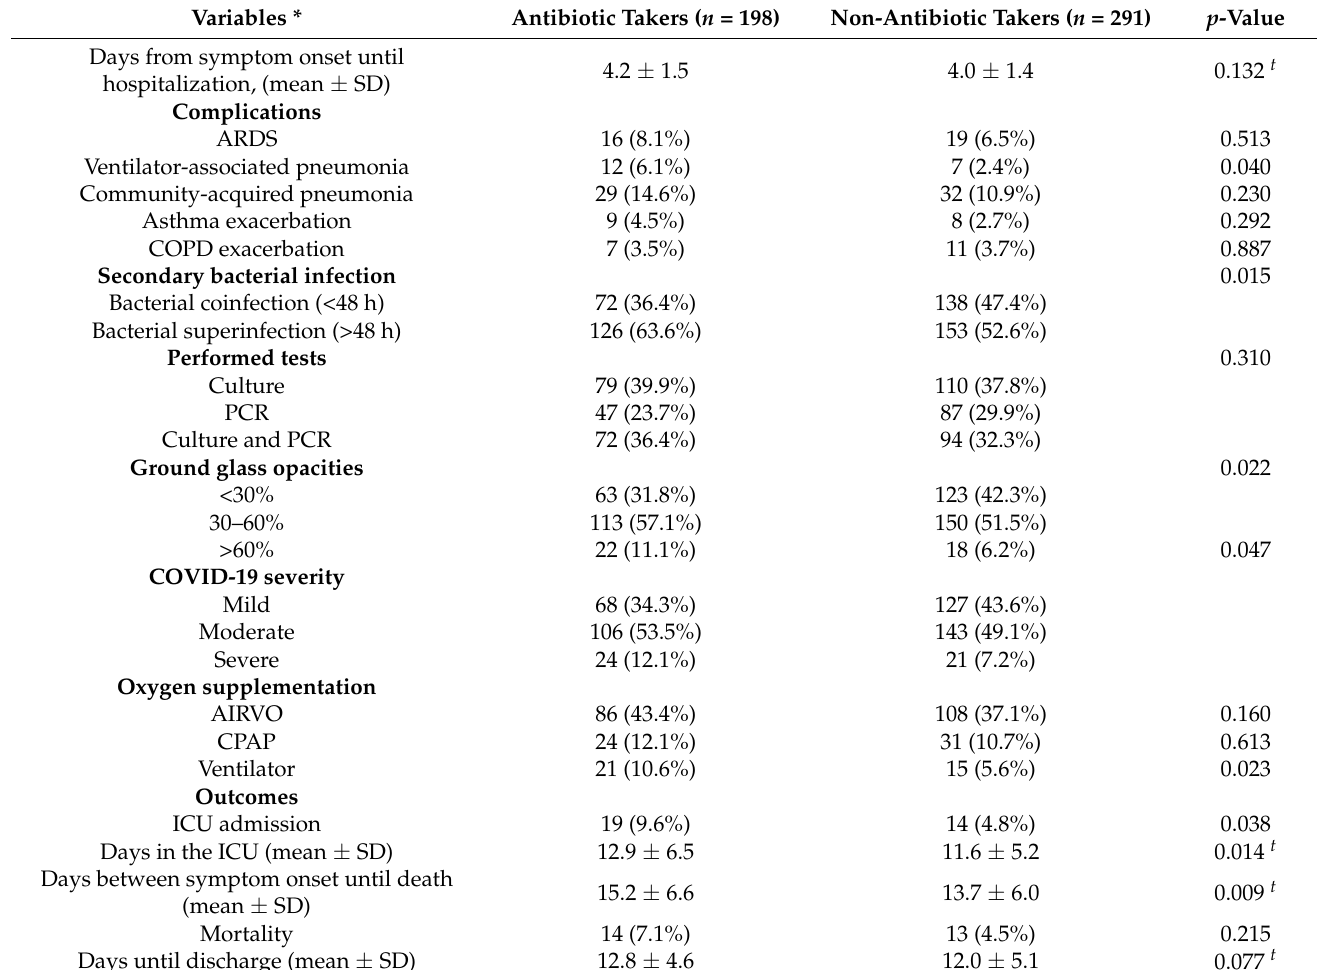
Table 2. Outcomes of COVID-19 patients with secondary bacterial infections stratified by antibiotic use